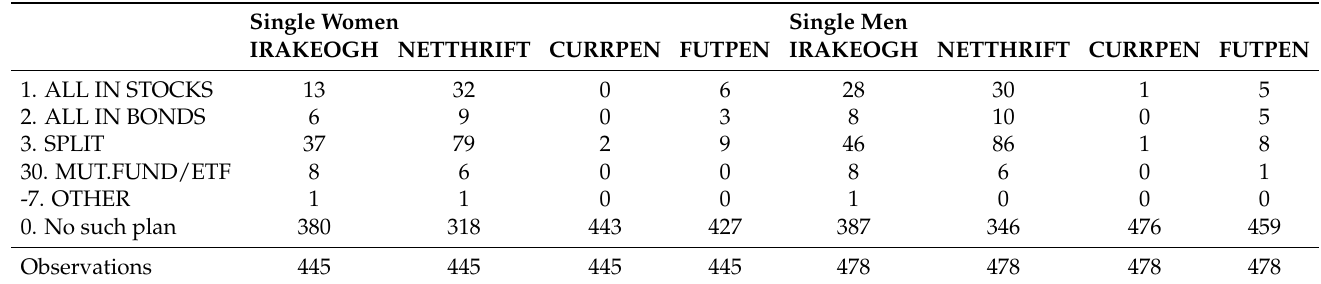
Table 4. How Do Single Women and Single Men Invest Their Retirement Wealth? By “Single” we Refer to “Never Married”